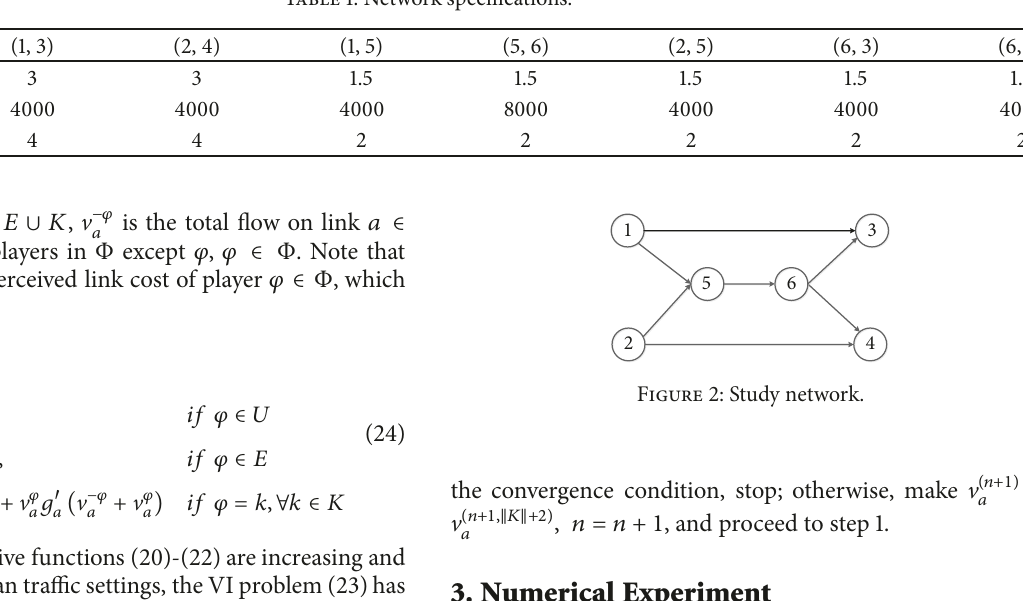
Table 1: Network specifications.